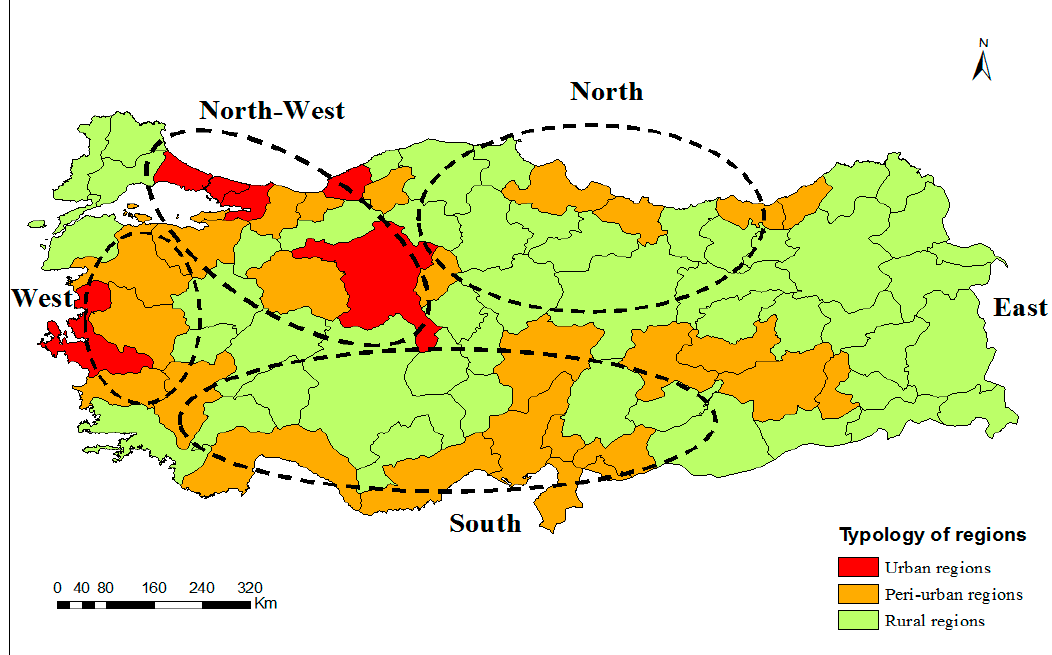
Figure 5. Typology of regions composed of urban, peri-urban and rural areas grouped by geographical zones in Turkey. Source: Figure adopted from Broitman and Koomen 17 .